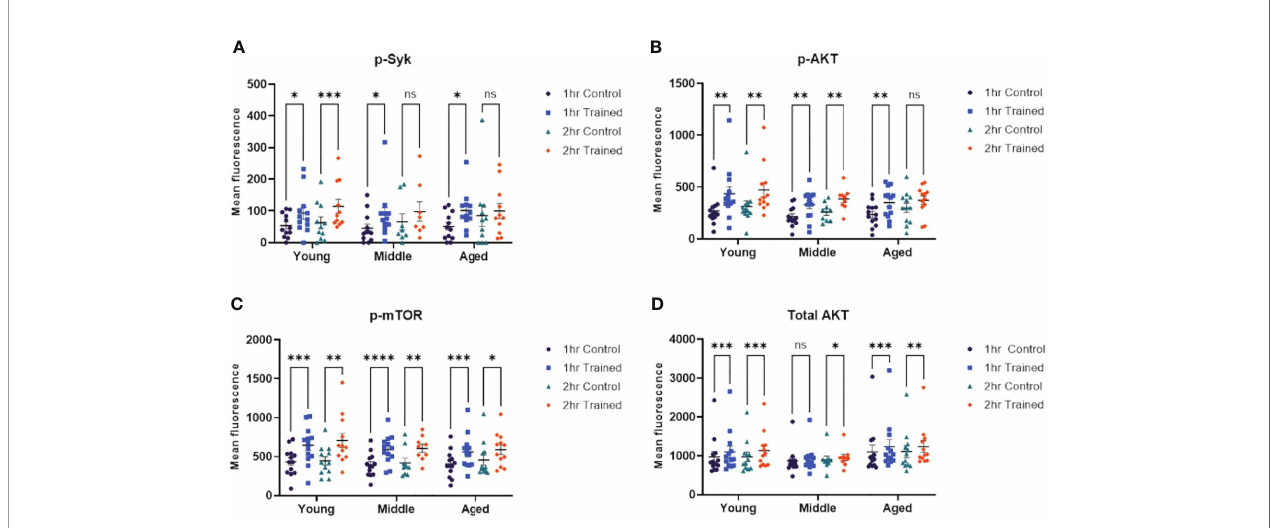
FIGURE 5 | Immune training activates intracellular signaling pathways in monocytes. (A) Scatterplot depicting phosphorylated – Syk 1 and 2 hours after b – glucan or PBS treatment (N=8 – 12). (B) Scatterplot depicting phosphorylated – AKT expression (N=9 – 13). (C) Scatterplot depicting phosphorylated – mTOR (N=9 – 13). (D) Scatterplot depicting total AKT expression (N=9 – 13). All results analyzed using a mixed – effect model and S ̌ ı ́ da ́ k ’ s multiple comparisons test (*P ≤ 0.05, **P ≤ 0.01, ***P ≤ 0.001, ****P ≤ 0.0001, ns, not signi fi